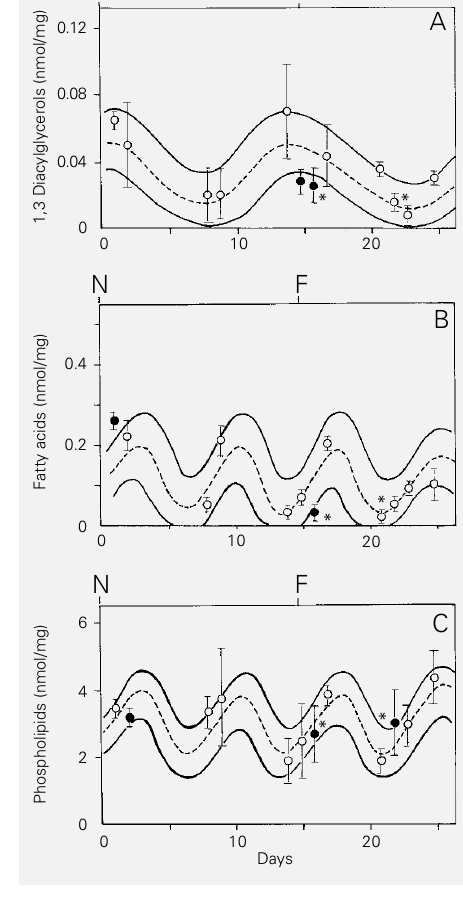
Figure 2 - Correlation of honey- bee hemolymph 1,3 diacylglyc- erol (A), fatty acids (B) and phos- pholipids (C) with days of the synodic lunar cycle. Data are re- ported as described in the leg- end to Figure 1 (means – SD, nmol/mg bee fresh